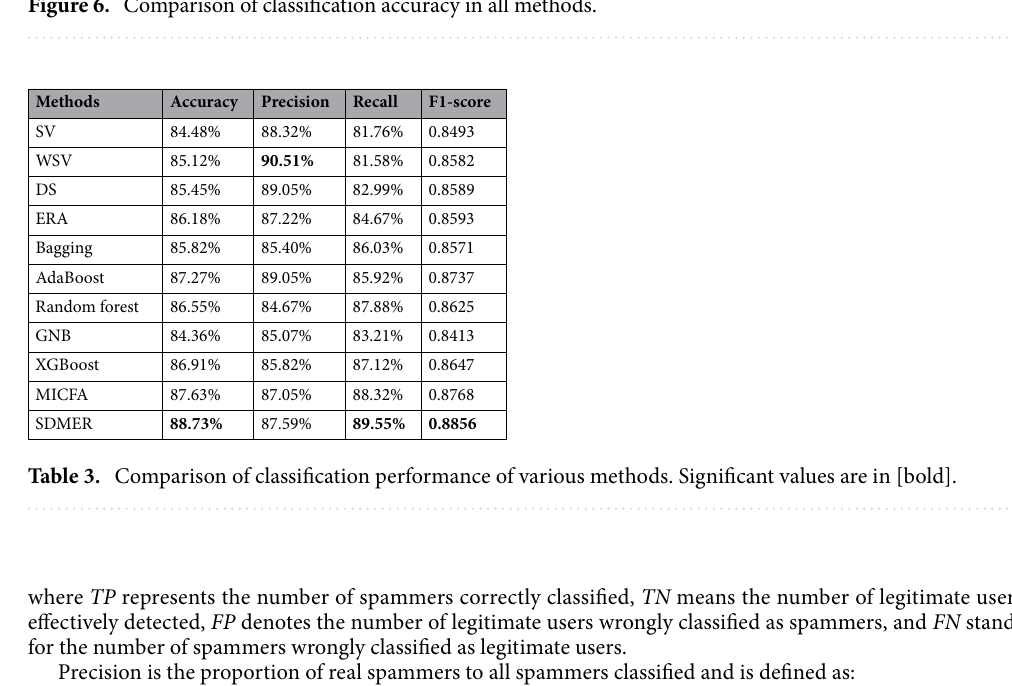
Figure 6. Comparison of classification accuracy in all methods.